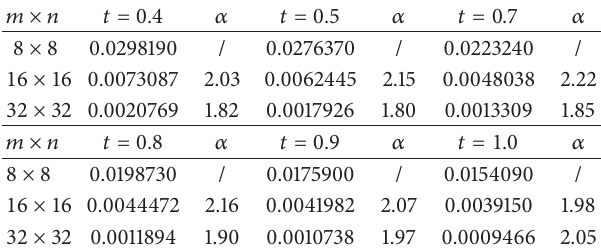
Table 2: Numerical results of ‖𝑢 − 𝑢 ℎ ‖